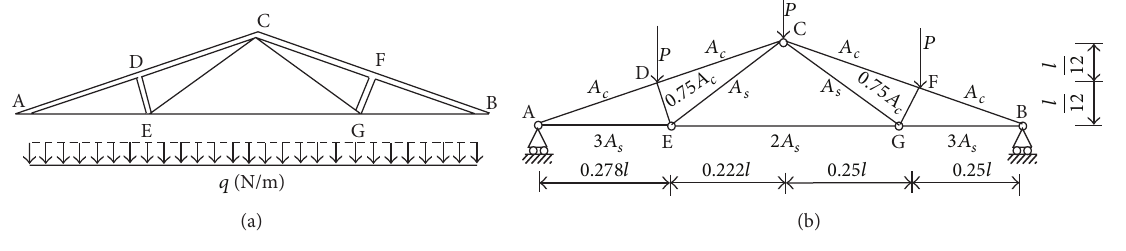
Figure 4: The schematic diagram of a roof truss.